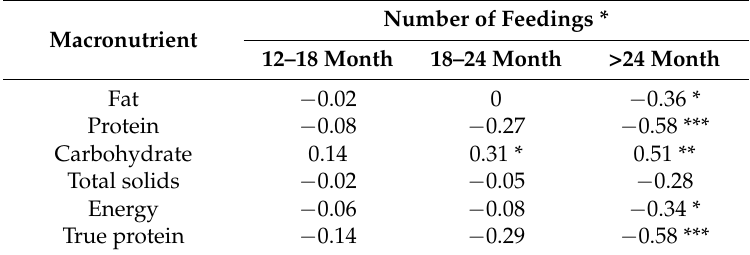
Table 5. The relationship between the number of feedings and macronutrient concentration in breast milk during prolonged